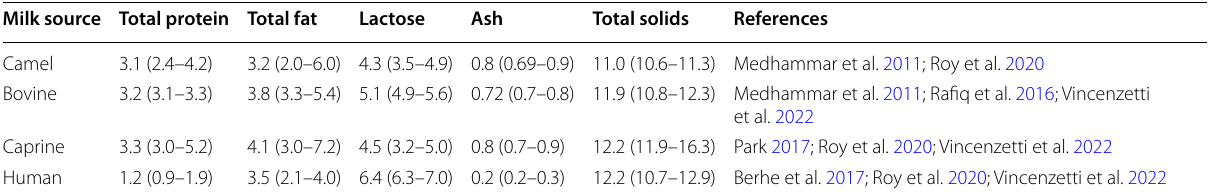
a Values in the Table are averages plus ranges indicated in parenthesis